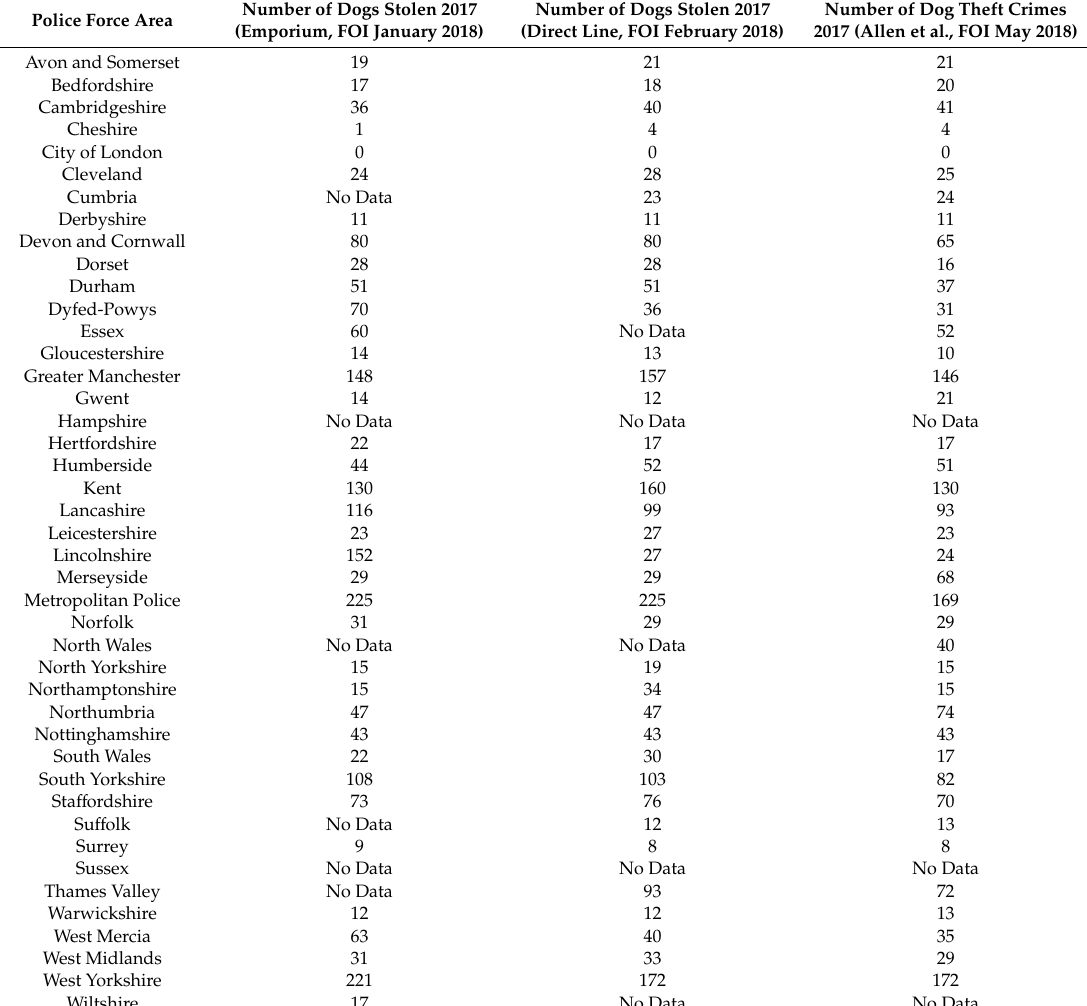
Table 6. Freedom of Information (FOI) data from Emporium, Direct Line and Allen et al. Police Force